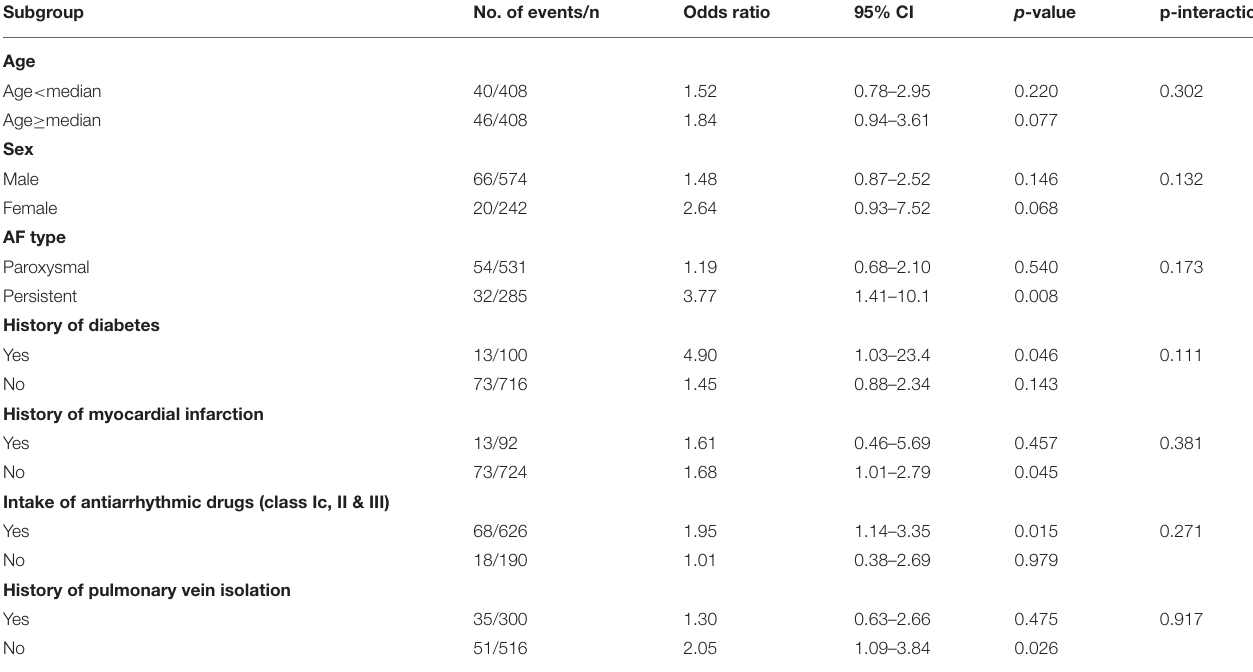
TABLE 3 | Association of heart rate variability triangular index and silent brain infarcts: subgroup analyses in the sinus rhythm group.